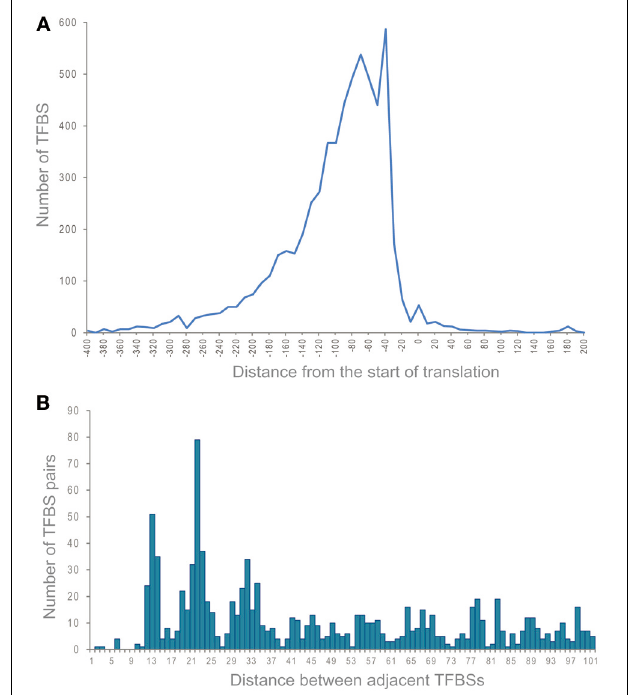
FIGURE 4 | Distribution of distances. (A) Distances between LacI-TF binding sites and the translational start sites. (B) Distances between adjacent binding